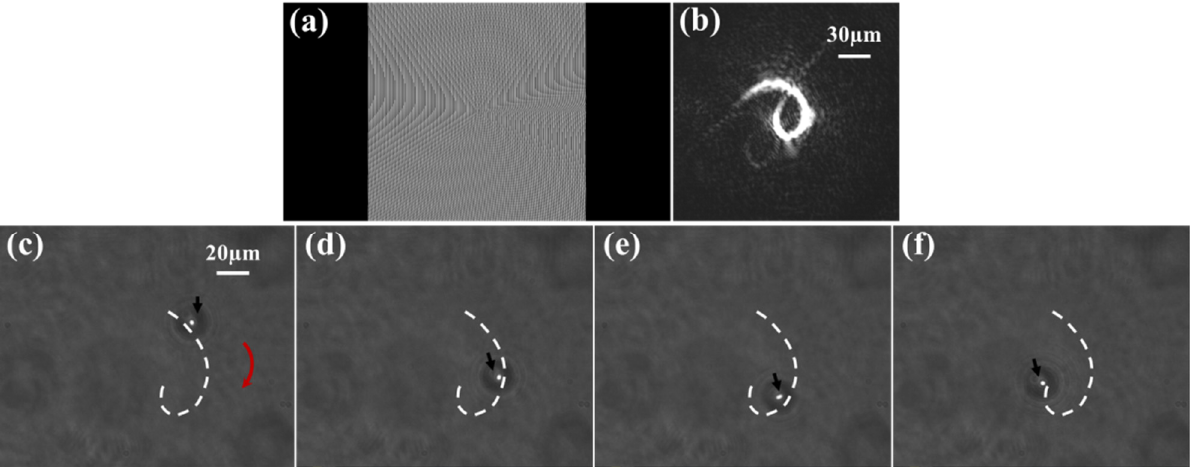
Figure 8. ( a ) The phase profiles used to generate the spoon-like beams with l = − 5, n = 0.4. ( b ) The reconstructed spoon-like beam at the focal plane of the objective. ( c – f ) The trapped microspheres moving automatically along the spoon-like trajectory of the generated beam with l = − 5, n = 0.4.